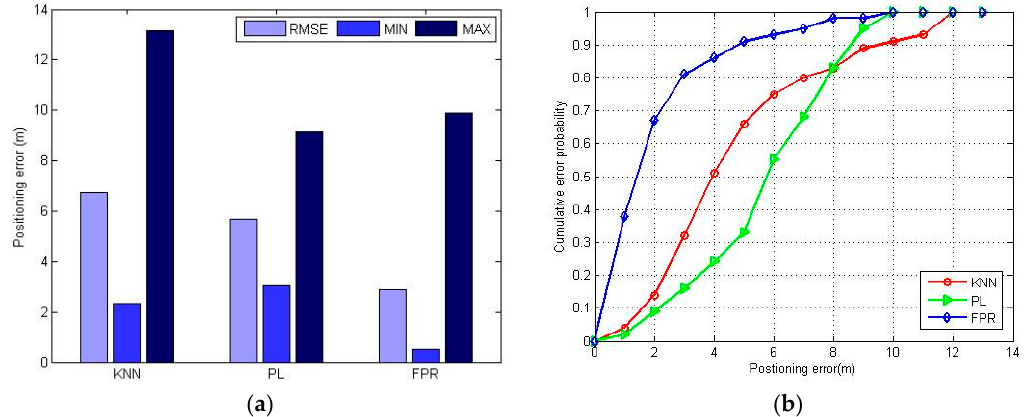
Figure 10. The positioning error of KNN, PL and FPR algorithm: ( a ) maximum positioning error, minimum positioning error and RMSE of different positioning methods; ( b ) CDF of different positioning methods.